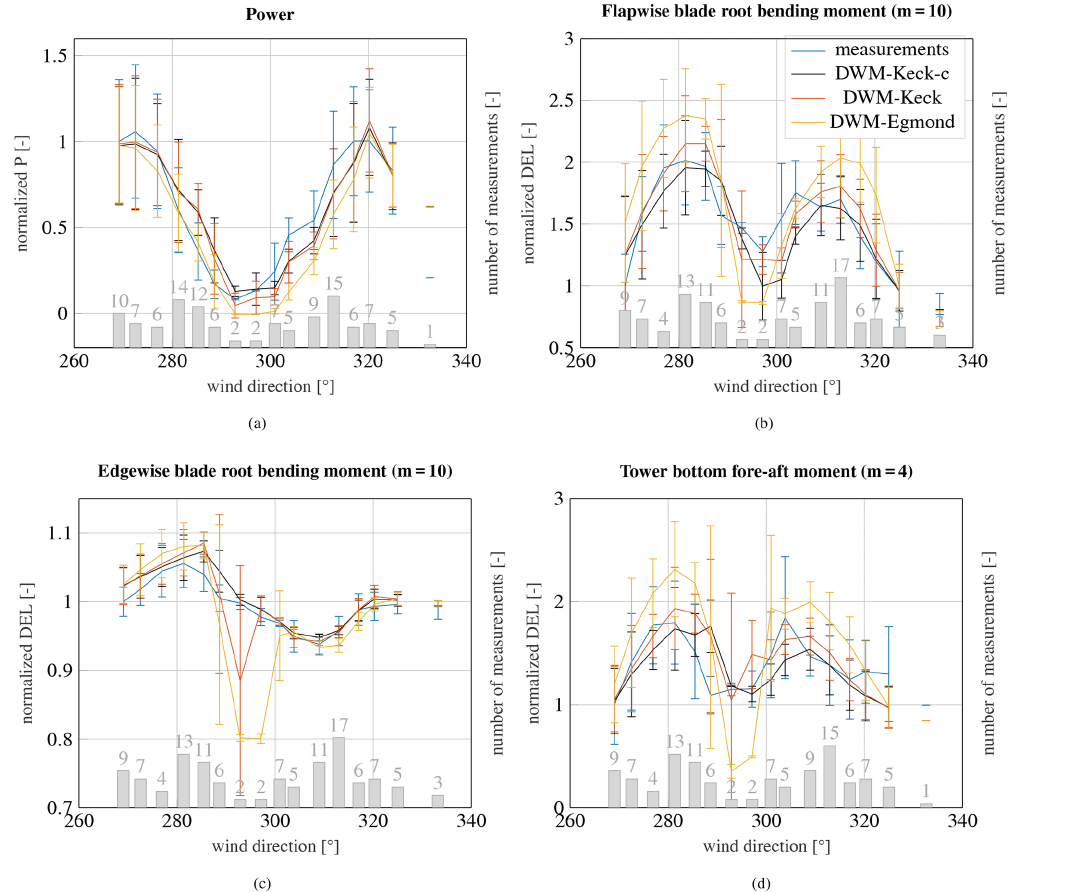
Figure 9. Measured and simulated power deficit (a) , flapwise blade root moment (b) , edgewise blade root moment (c) and tower bottom fore-aft moment (d) at WTG 2 at an ambient wind speed of 6ms − 1 and an ambient turbulence intensity of 6%. WTG 2 is exposed to the wake of WTG 1. The number of measured 10min time series in each wind direction bin is illustrated on the secondary